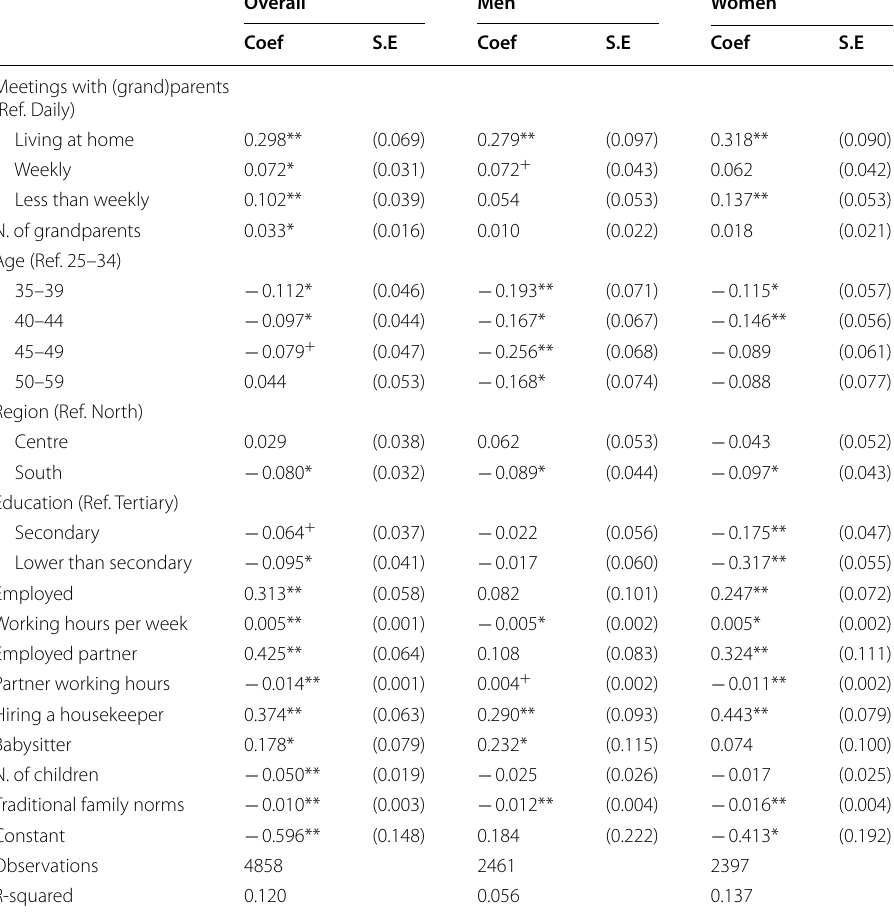
Table 8 Linear regression models on symmetry in the division of routine and instrumental housework tasks (5 items) ( Z